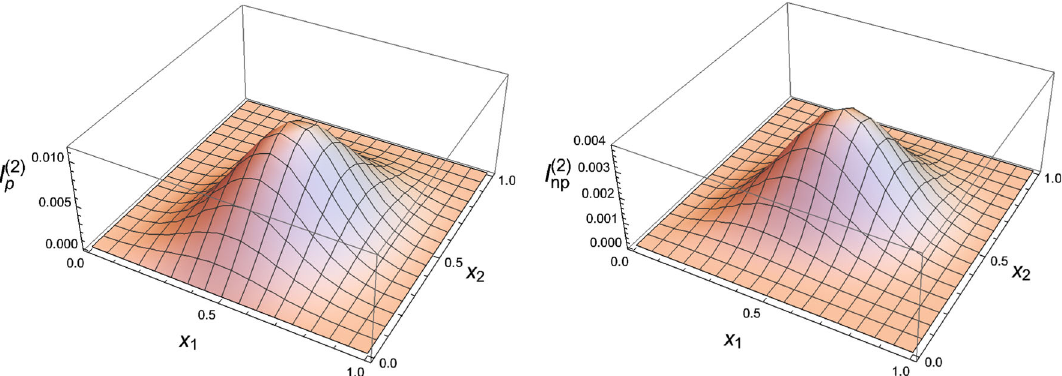
Fig. 7 Numerical stability of the integrands of the two-loop planar (left) and non-planar (right) scalar triangles of Fig. 6 as a function of x 1 and x 2 with fixed values for the angles θ